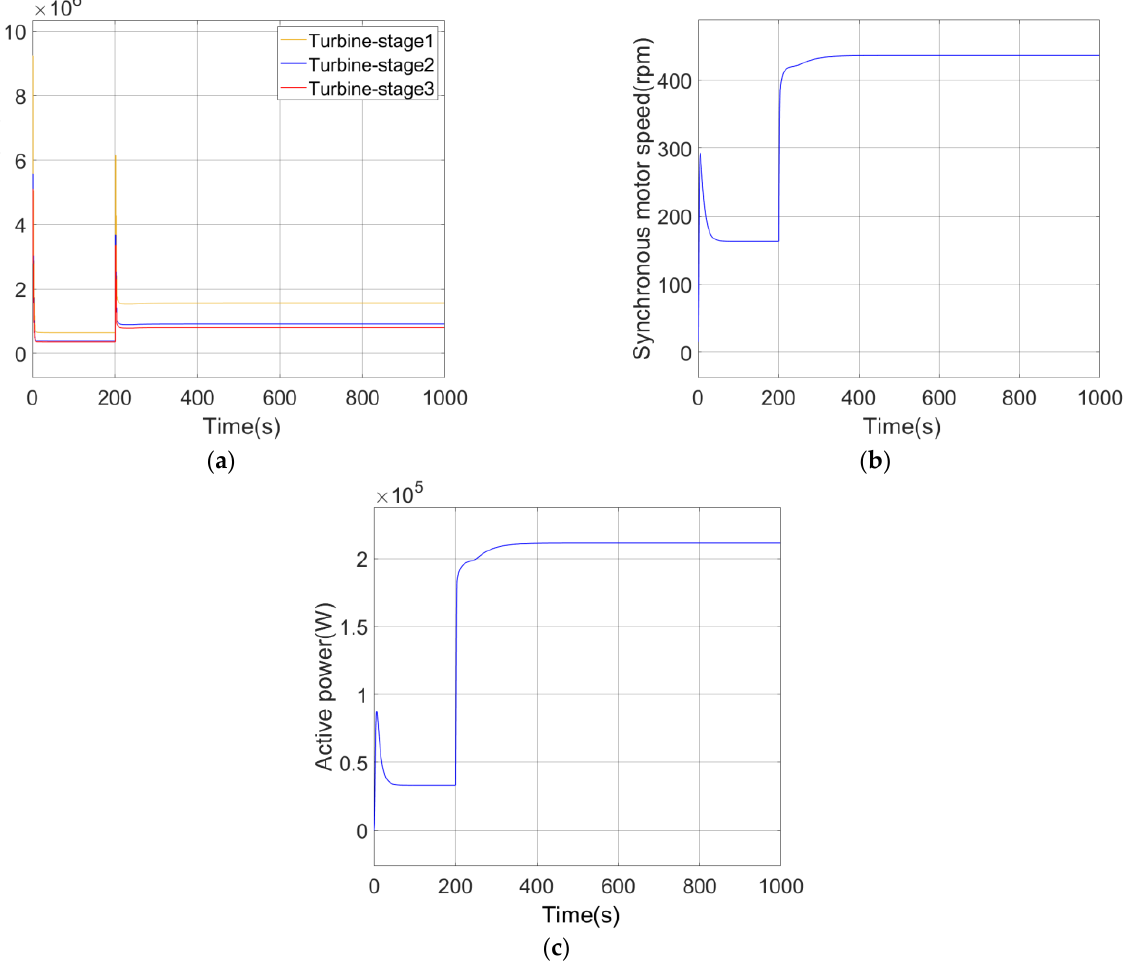
Figure 41. Simulation results of AA-CAES system participating in microgrid voltage regulation in case of a generator failure: ( a ) Change in air pressure in cylinder of piston compressor; ( b ) Speed change in synchronous generator; ( c ) Change in power generated by the system.